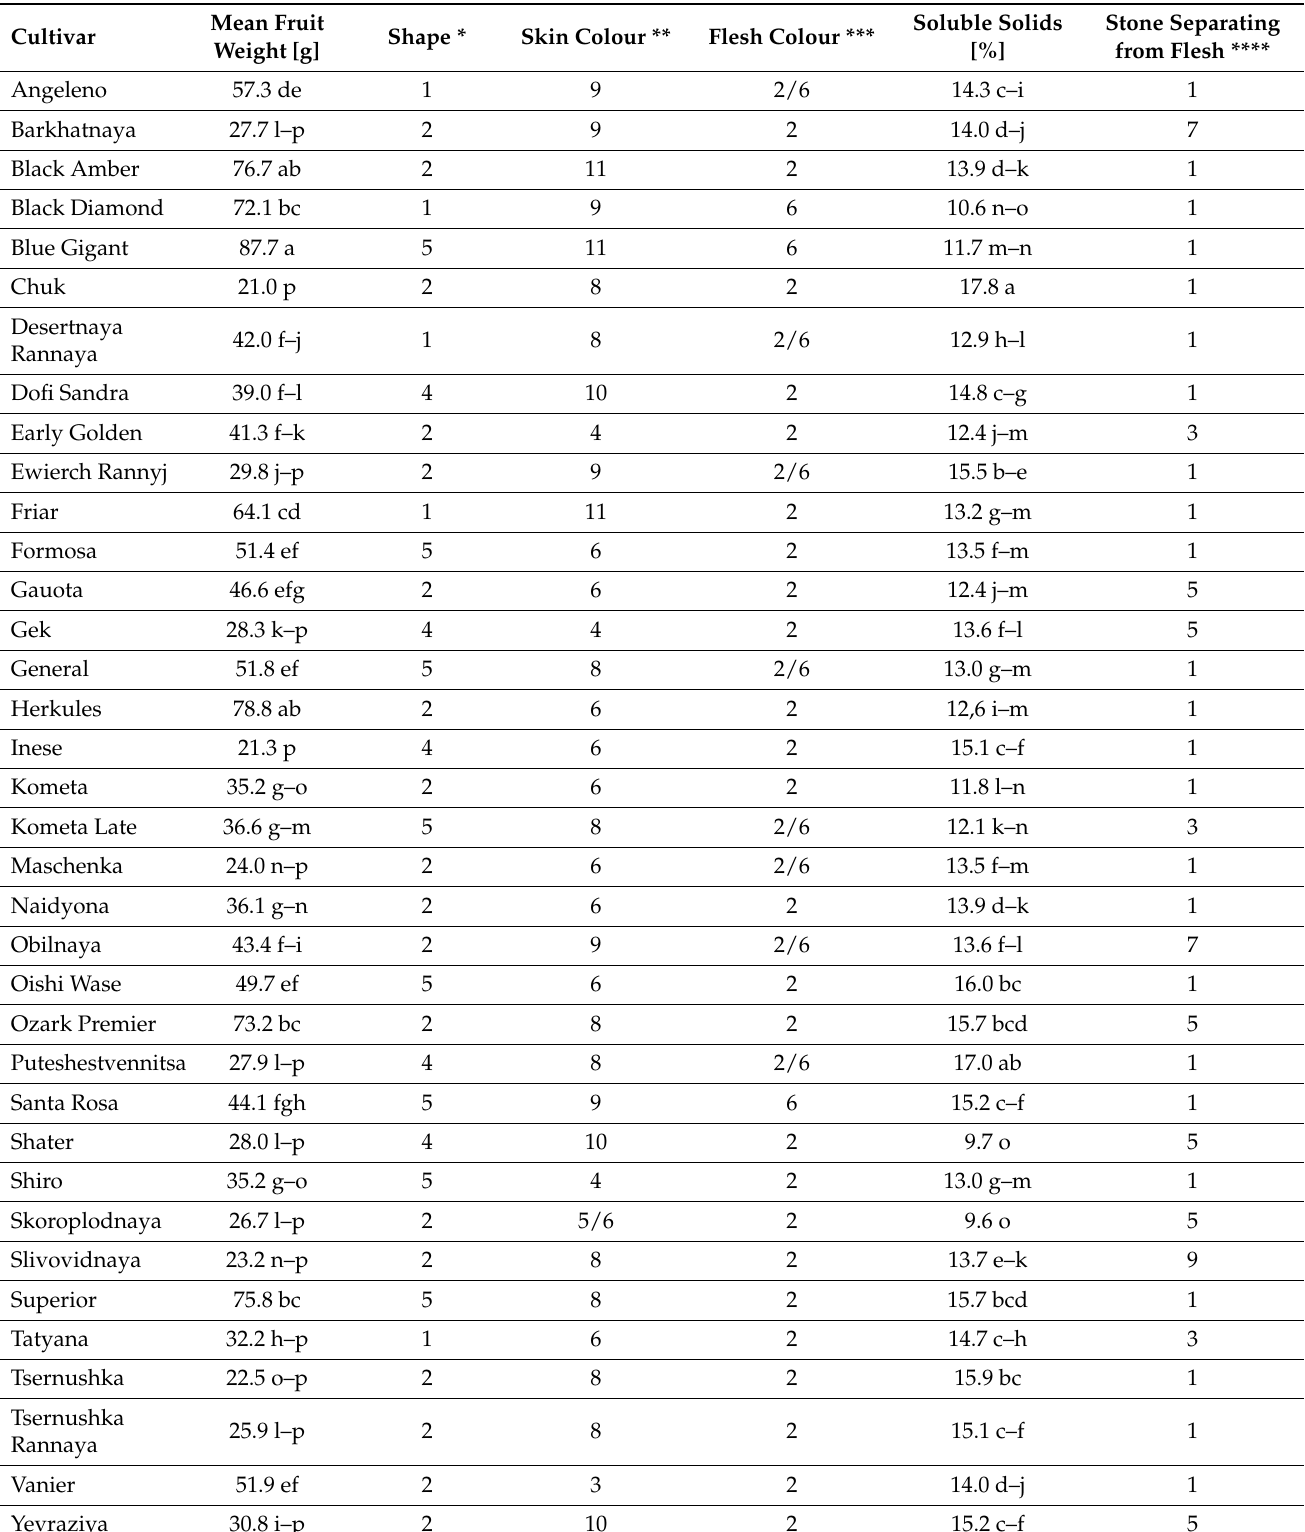
Table 3. Fruit characteristics of 36 P. salicina cultivars (average,